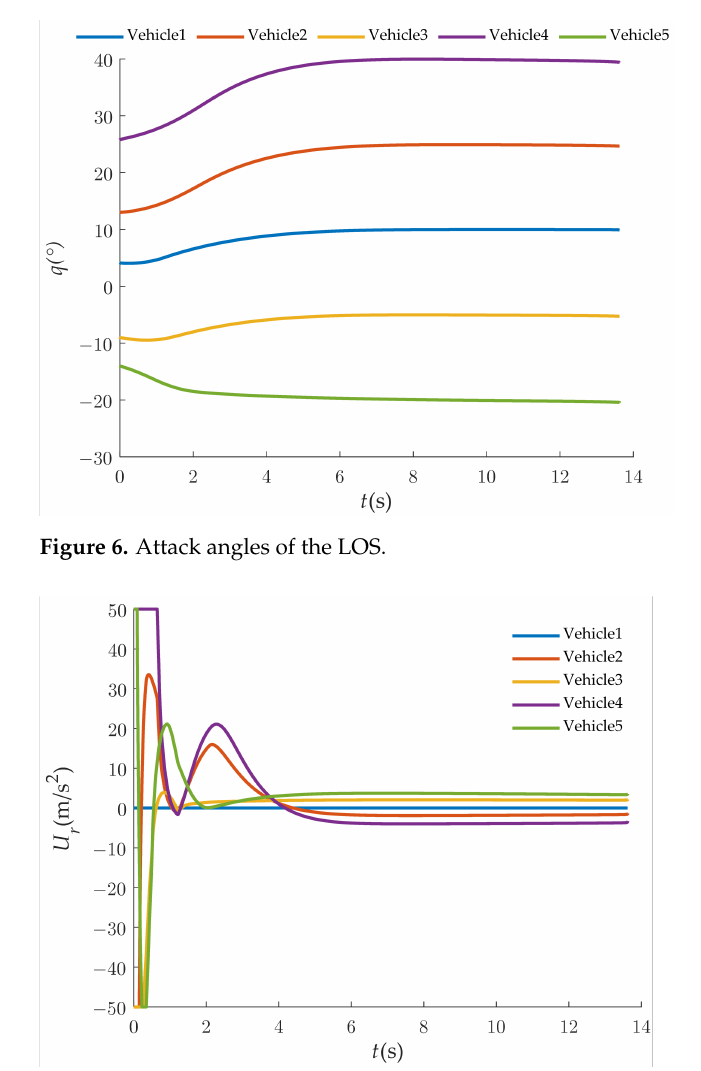
Figure 5. Time-to-go of multiple vehicles.